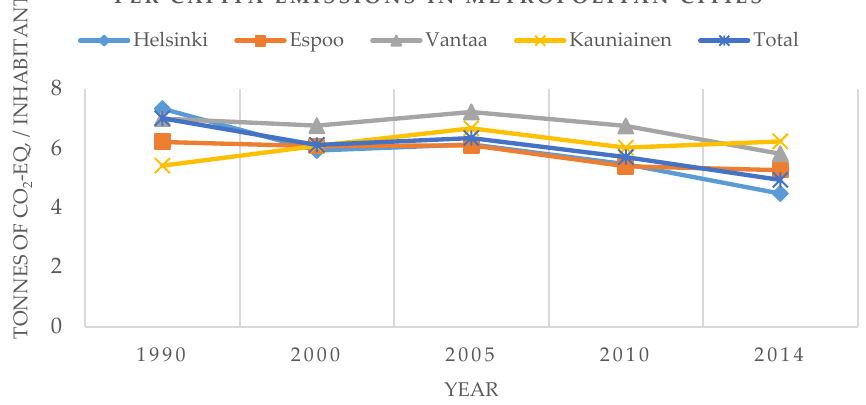
Figure 5. Per capita emissions in the Helsinki metropolitan cities [15].